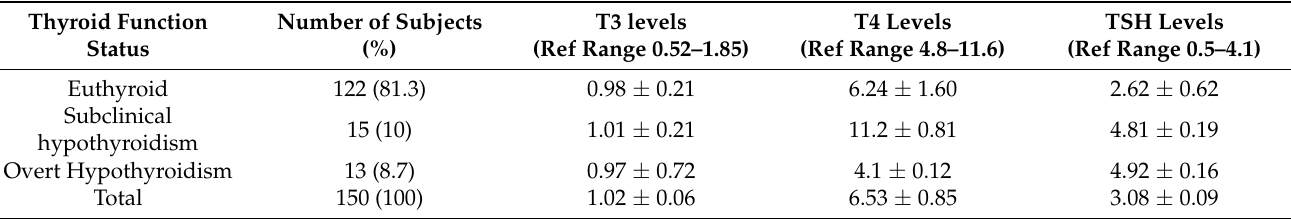
Table 6. Distribution of thyroid dysfunction among hypertensive pregnant women.